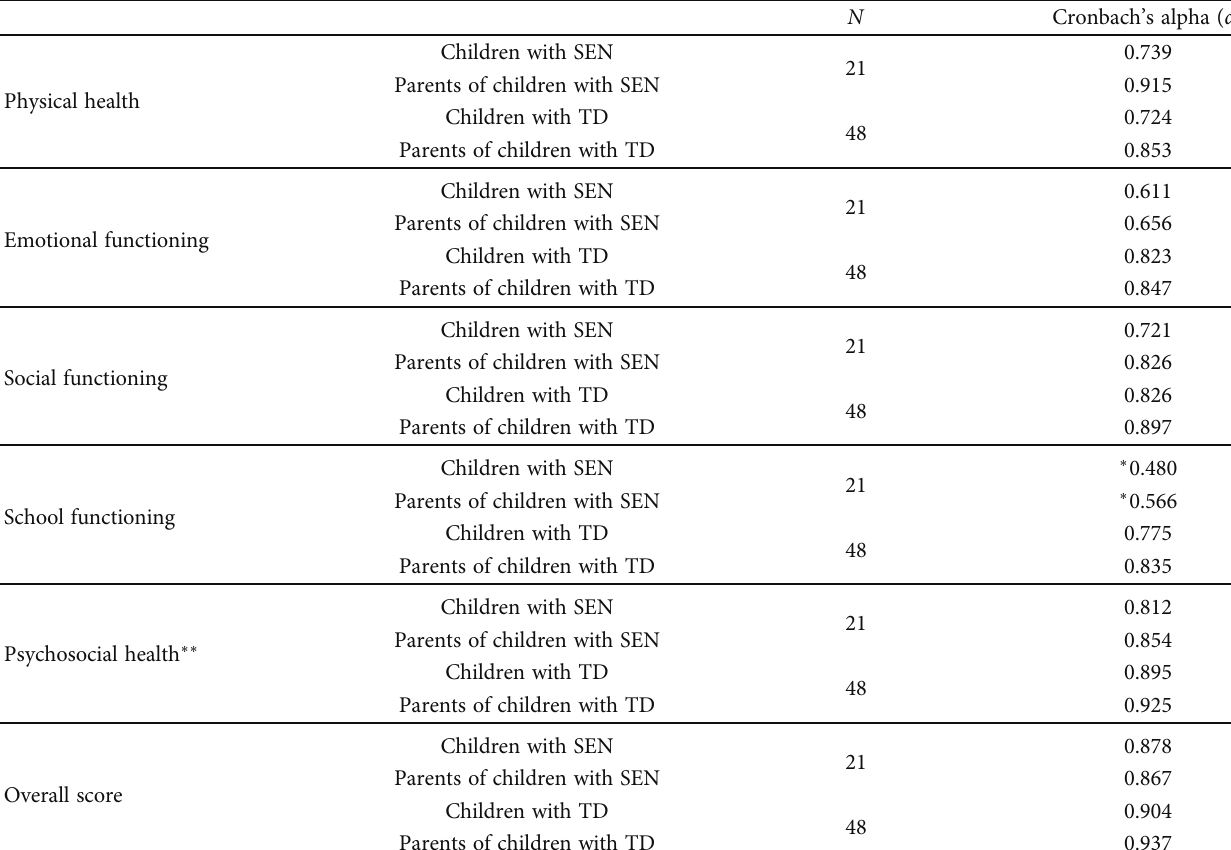
Table 3: Internal consistency reliability of the scale and its subscales between TD and SEN children and parent groups.